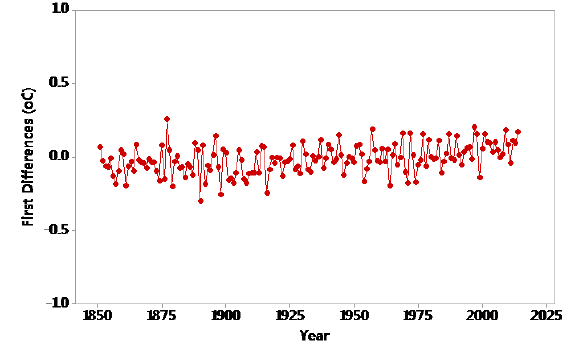
Figure 4: Hadley SST3 yearly averaged global temperature anoma- lies ( ∘ C) relative to 1961–1990 (Met Oflce Hadley Centre, 2015). Figure 5: Year-by-year temperature changes. The first differences were calculated using; ∆T = T t − ρT t −1 , ρ = 0.82